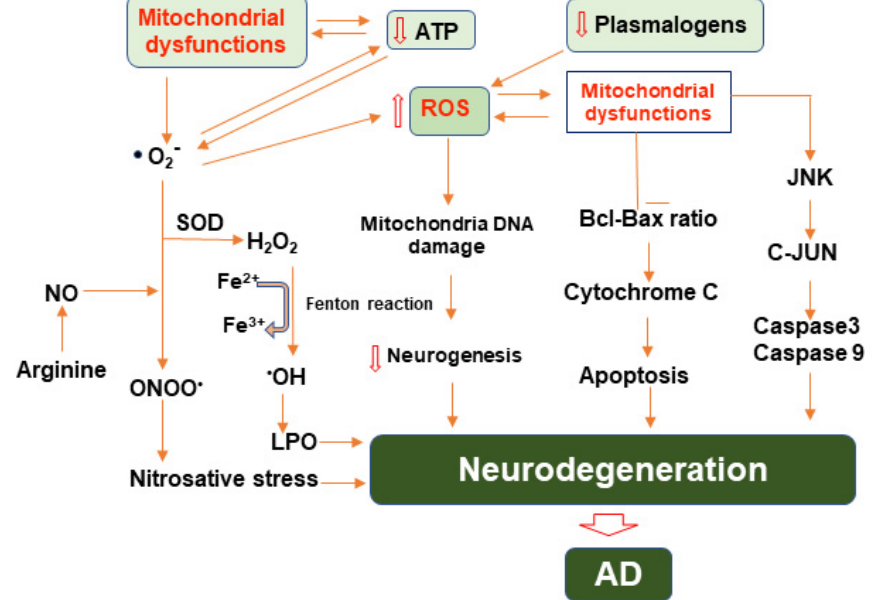
Figure 2. Illustration of molecular pathways involving mitochondrial dysfunction, reactive oxygen and nitrogen species, and their roles in the progression of neurodegeneration in AD. Mitochondrial dysfunction leads to enhanced generation of reactive oxygen species, primarily superoxide, which then may be converted to other ROS or combined with nitric oxide ultimately causing nitro-oxidative stress. ROS and RNS may also damage mitochondrial DNA and restrict neurogenesis. Mitochondrial dysfunction also contributes to the induction of apoptotic pathways involving Bcl/BAX and JNK ultimately exacerbating neurodegeneration.